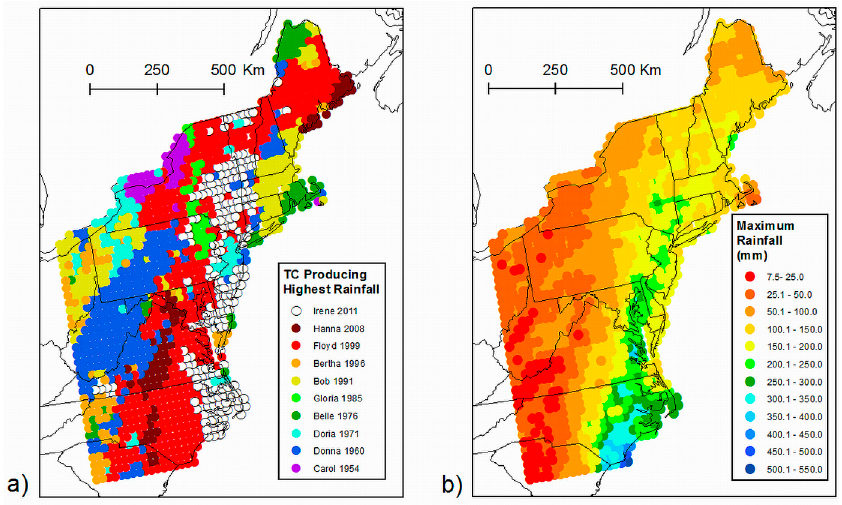
Figure 10. ( a ) Tropical cyclone producing the highest storm-total rainfall for each grid point; ( b ) storm total rainfall (mm) for each grid point produced by corresponding tropical cyclone in ( a ).